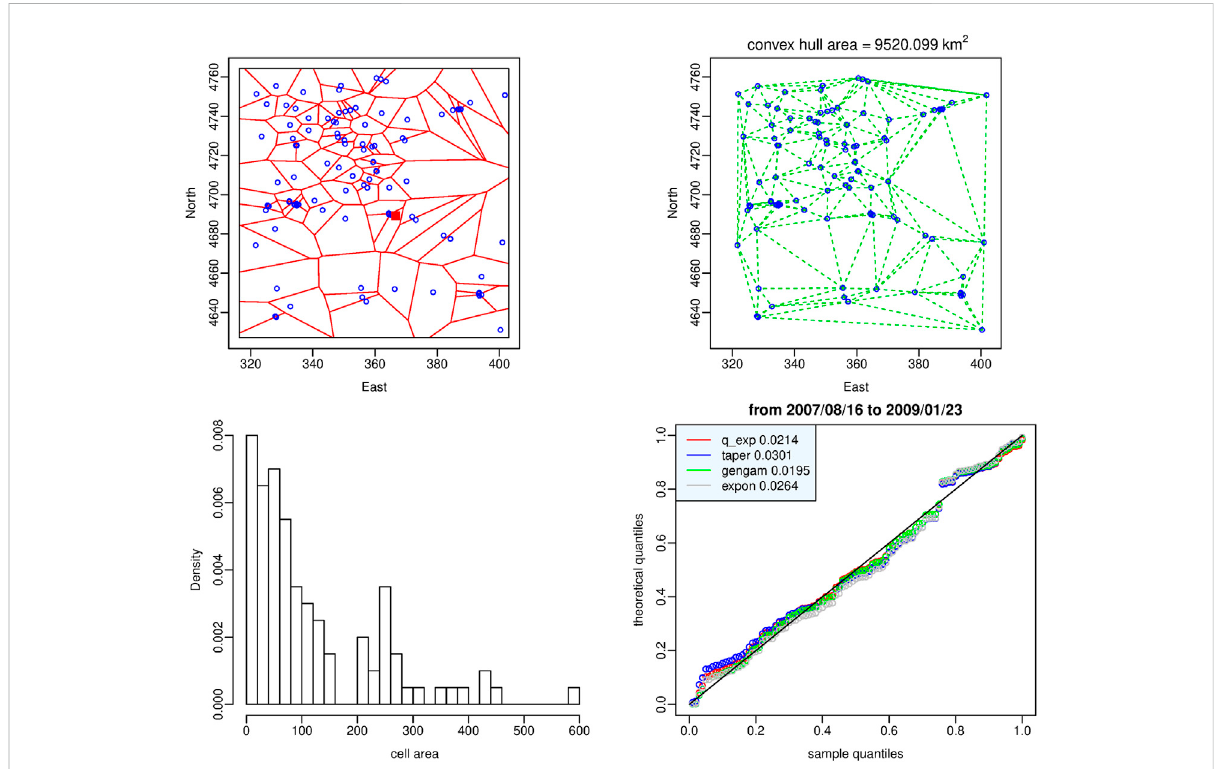
FIGURE 7 Dataset of thetime window in which the exponential distribution provides the best fi t. Top: Voronoi tessellation(left-handpanel) and Delaunay triangulation (right-hand panel). Bottom: histogram of the cell areas (left-hand panel) and Q-Q plot of the four probability distributions (right-hand panel). Red square indicates the epicenter of L ’ Aquila shock.